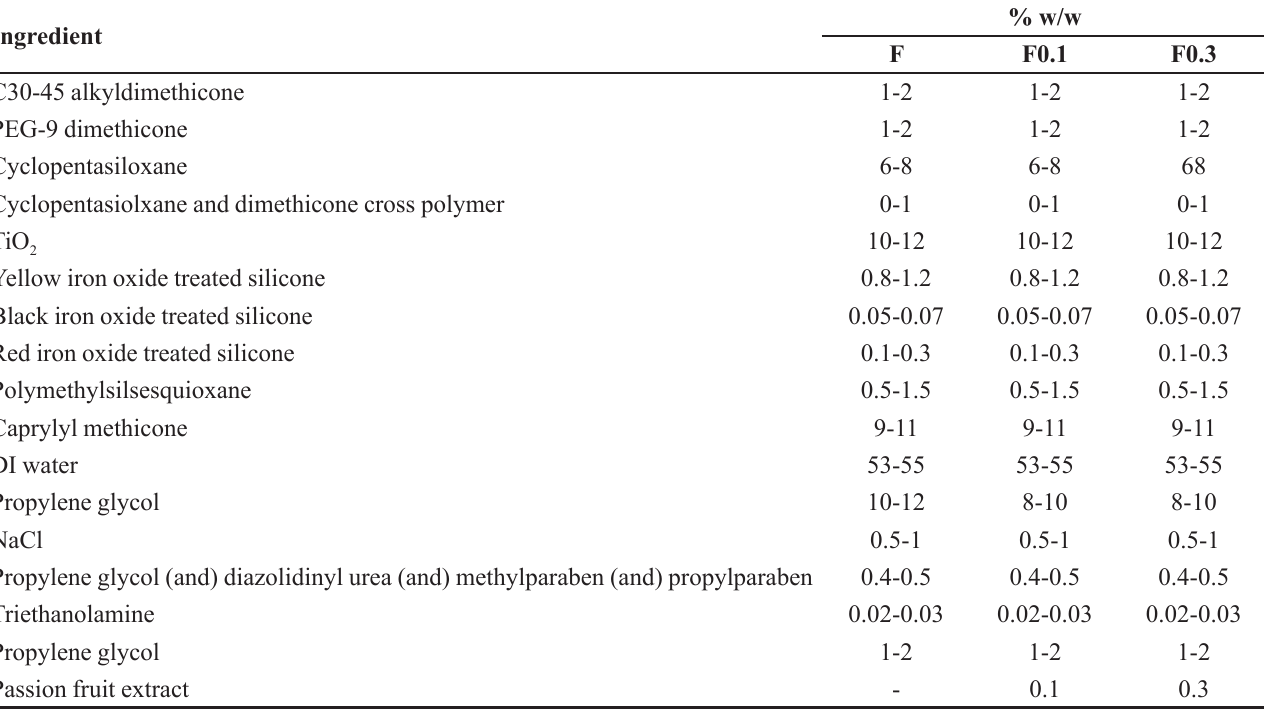
TABLE I - Composition of the liquid foundation